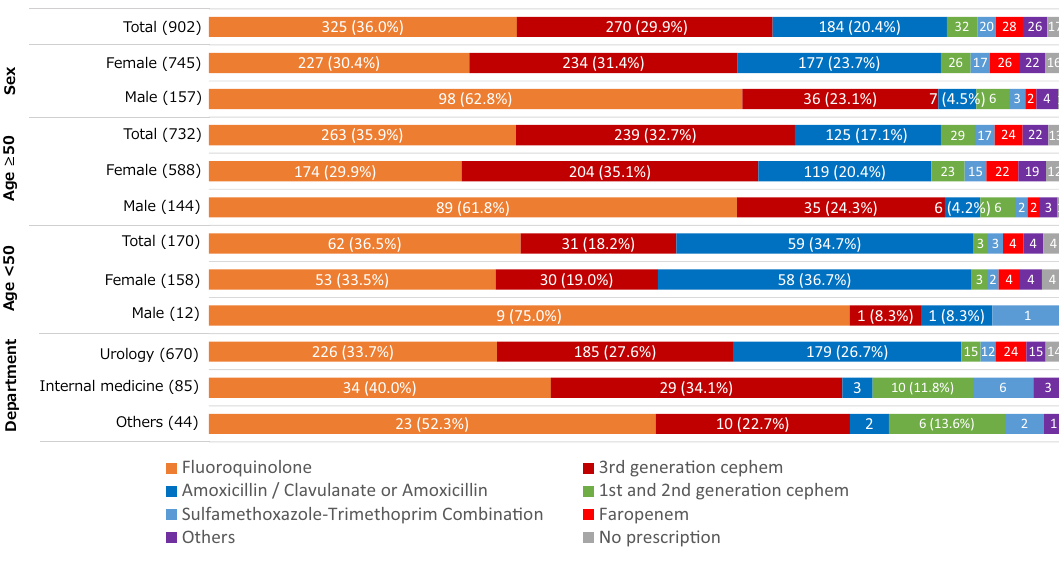
Figure 2. These are details of antimicrobial prescriptions for cystitis by sex, age group, and consulting